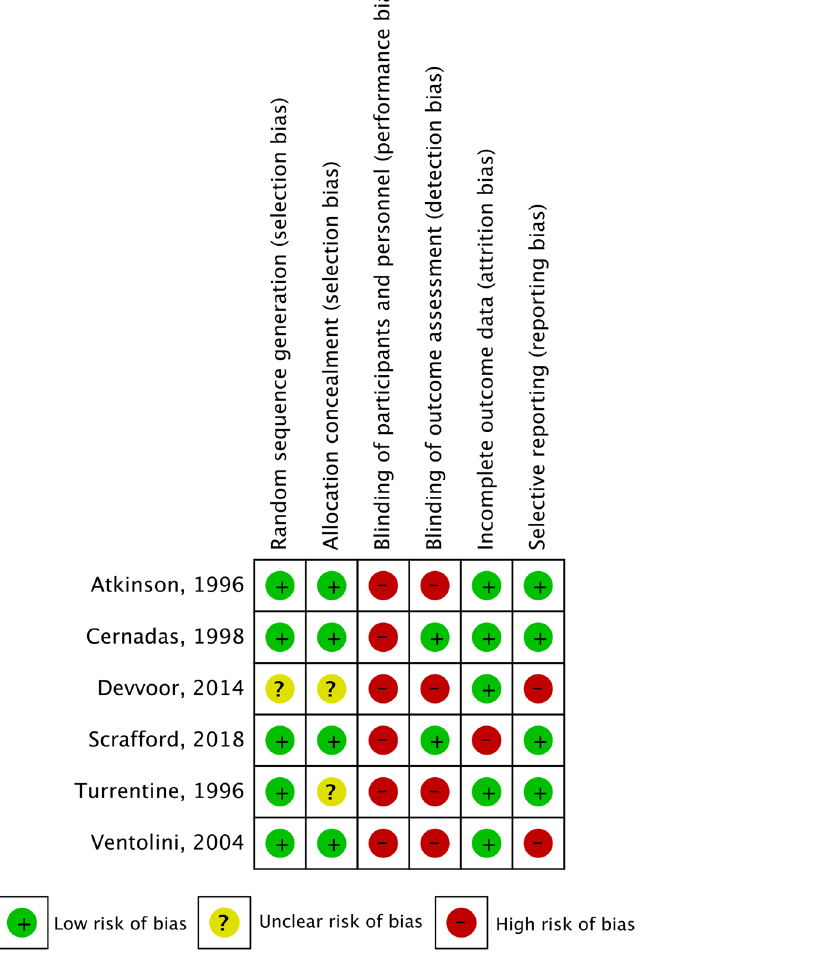
Figure 2. Summary risk of bias of included